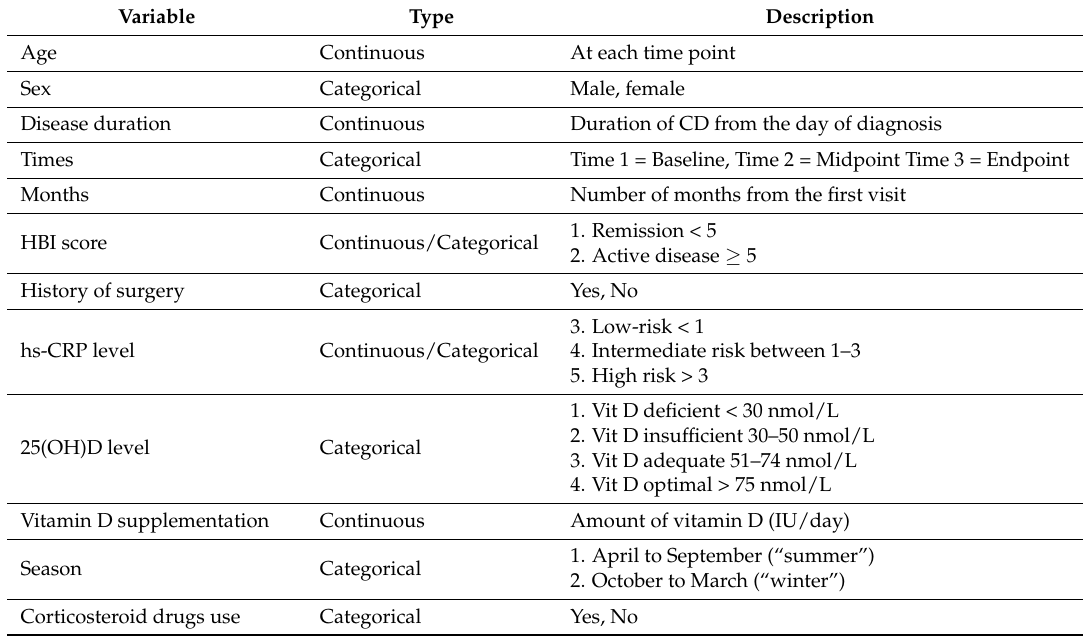
Table 1. Definitions of Variables Used in the Data